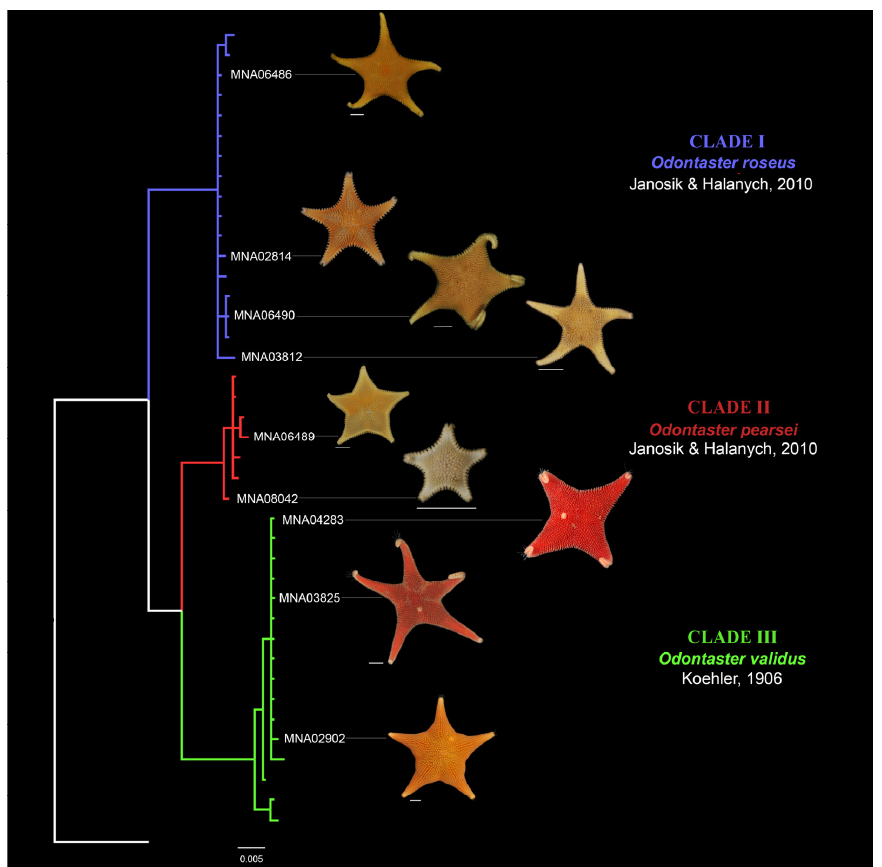
Figure 4. Odontaster morphology variability of selected specimens. In the tree highlighted in blue: O. roseus Janosik & Halanych, 2010, characterized by an orange coloration; red: O. pearsei Janosik & Halanych, 2010, characterized by an orange coloration; green: O. validus Koehler, 1906, with dark pink/red or orange coloration. Scale bar: 1 cm in grey.